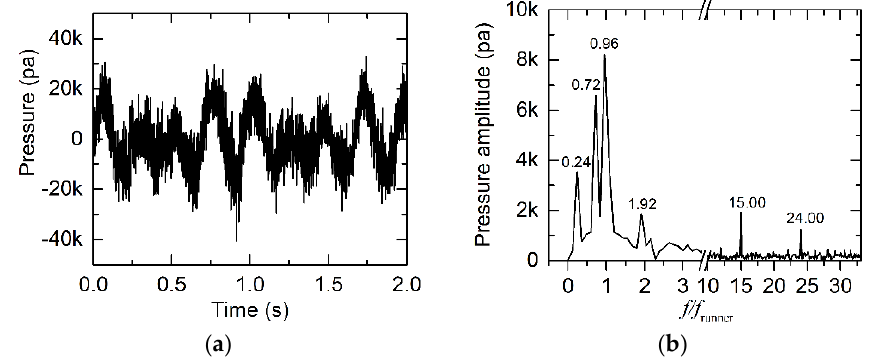
Figure 11. Pressure fluctuations of R 1p in the runner blade (16 deg GVO): ( a ) time history record and ( b ) normalized frequency spectrum.